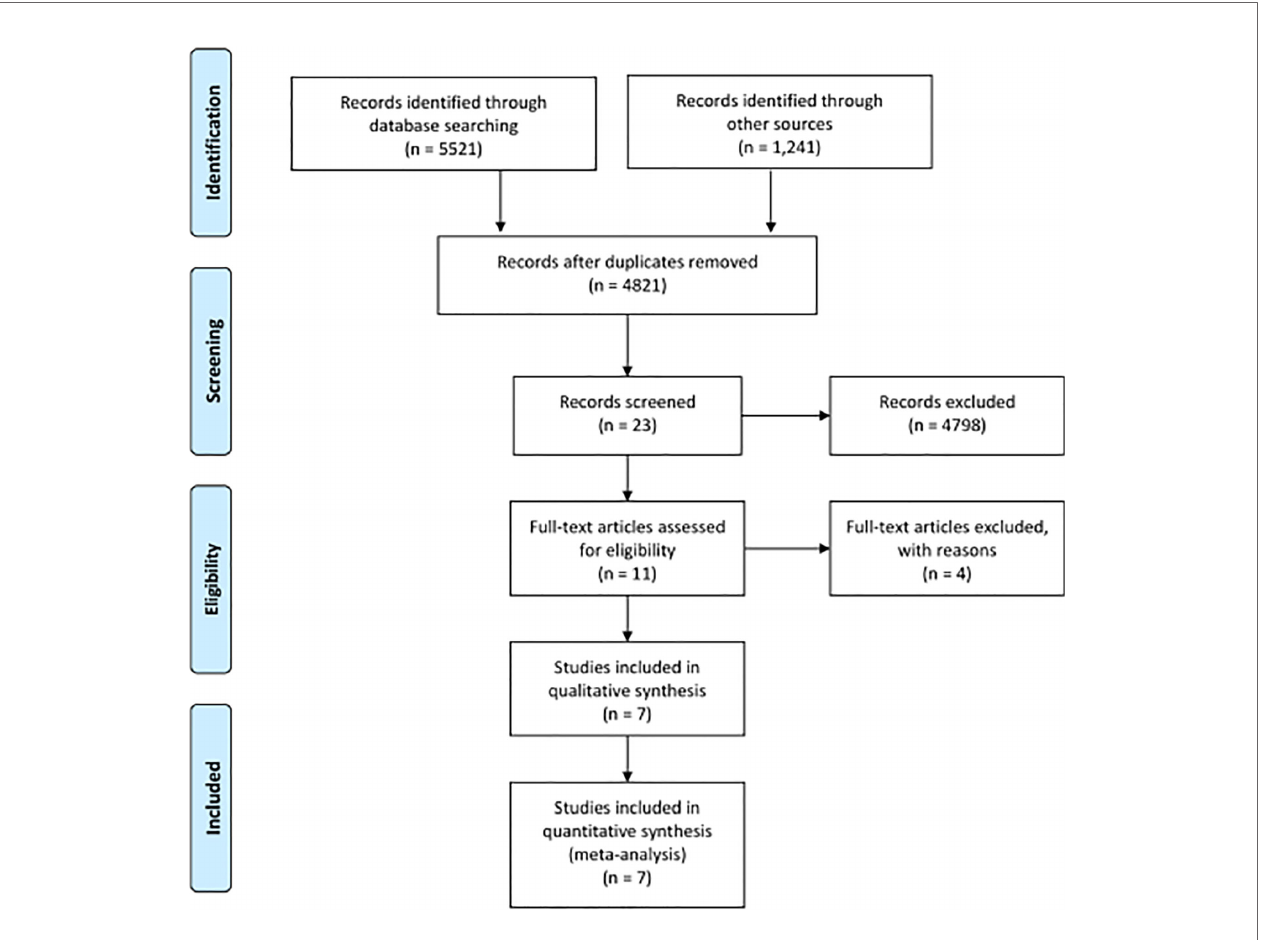
FIGURE 1 | The PRISMA 2009 fl ow diagram.